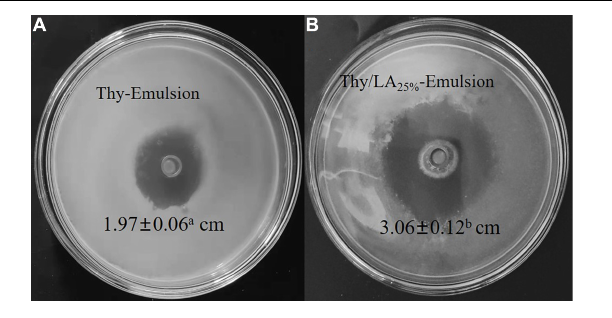
FIGURE 6 | The Zone of Inhibition of Thy-Emulsion (A) and Thy/LA 25% -Emulsion (B) against Listeria monocytogenes . n = 6.